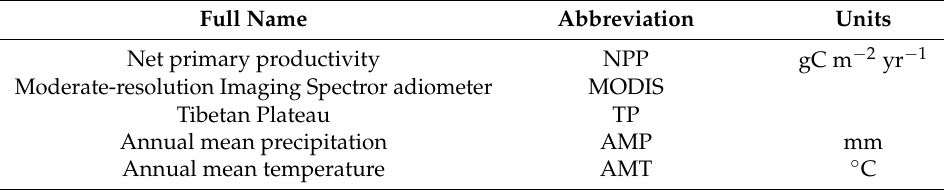
Table 1. The abbreviations used frequently in our